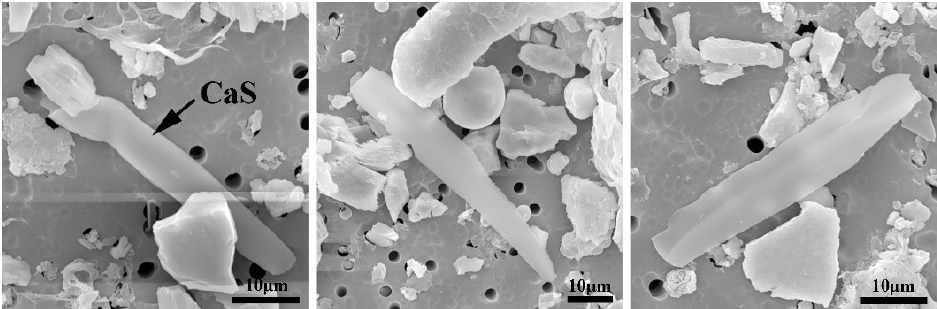
Figure 8. Three-dimensional morphology following inclusions of CaS under furnace-cooling conditions.